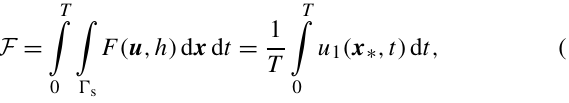
Examples of F( u ,h) in (14) are F = (cid:107) u − u obs (cid:107) 2 ,